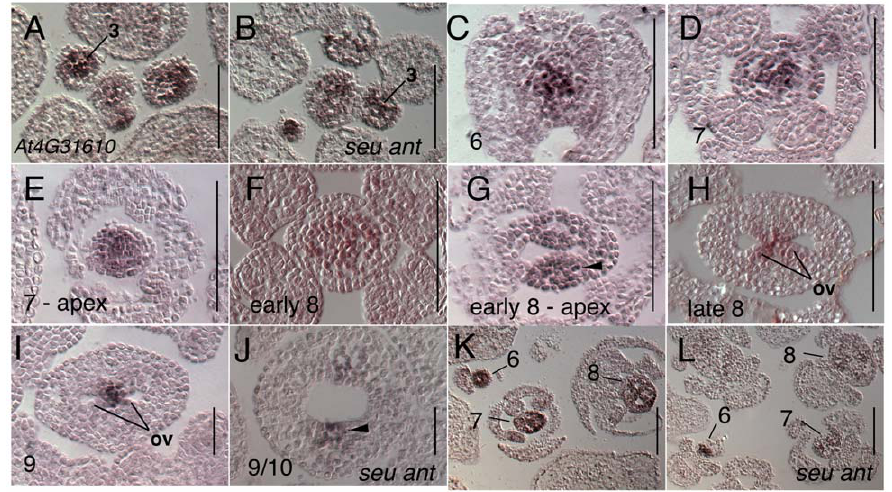
Figure 3. Results of insitu hybridization with At4G31610 ( REM34/AtREM1) antisense probe. Numbers indicate floral stages. All panels show transverse (cross sectional) tissue orientation. Arrowheads indicate medial domain expression; ov - ovule. All scale bars are 100 microns. All panels are Col-0 wild type tissue unless otherwise indicated.